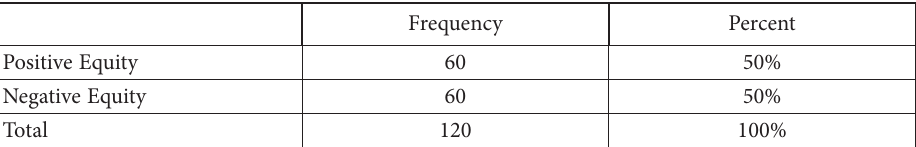
Table 7. Absolute and relative frequencies of polarity in the case of equity (source: author based on Bisnode MagnusWeb) Frequency Percent Positive Equity 60 50% Negative Equity 60 50% Total 120 100%